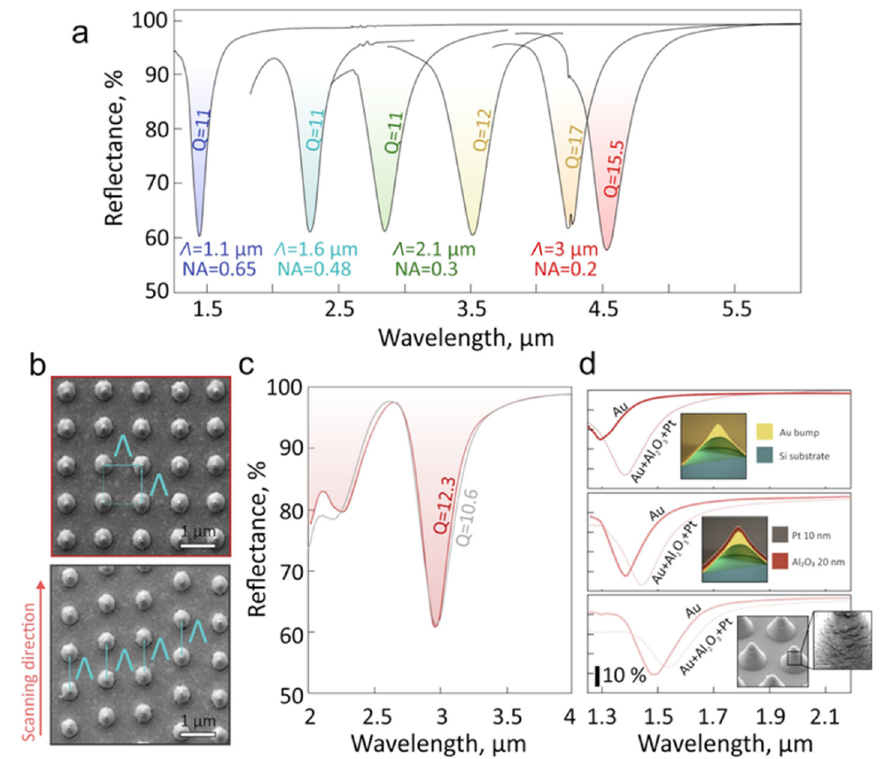
Figure 3. ( a ) Series of representative FTIR reflection spectra of the nanobump arrays exhibiting the highest CPR Q-factor for the different combinations of Λ , E and effective NA of the focusing objective. All nanostructure arrays were produced by gradually increasing laser fluence from 0.213 to 0.265 J/cm 2 from left to right. ( b ) Top-view SEM images of the nanobump arrays ( Λ = 2 µ m and E = 4.5 nJ) fabricated in square and disordered arrangements and their corresponding FTIR reflectance spectra. ( c ) FTIR reflection spectra of the nanobump arrays produced with (top) and without (bottom) synchronization of the femtosecond laser system with the nanopositioning stages. Both arrays were printed at fluence of 0.24 J/cm 2 and NA = 0.3. ( d ) Series of FTIR reflectance spectra of the nanostructure arrays before (solid curves) and after their consecutive capping with a 20 nm thick Al 2 O 3 layer and a 10 nm thick Pt layer (dashed curves). The nanostructure arrays were produced at Λ = 1 µ m and applied pulse energy E = 1.6 (top), 2.5 (middle) and 2.9 nJ (bottom) using NA = 0.65. Top inset schemes compare the nanobump geometry, while the bottom inset SEM images illustrate the nanoscale morphology of the coated nanobump. Scale bar is 100